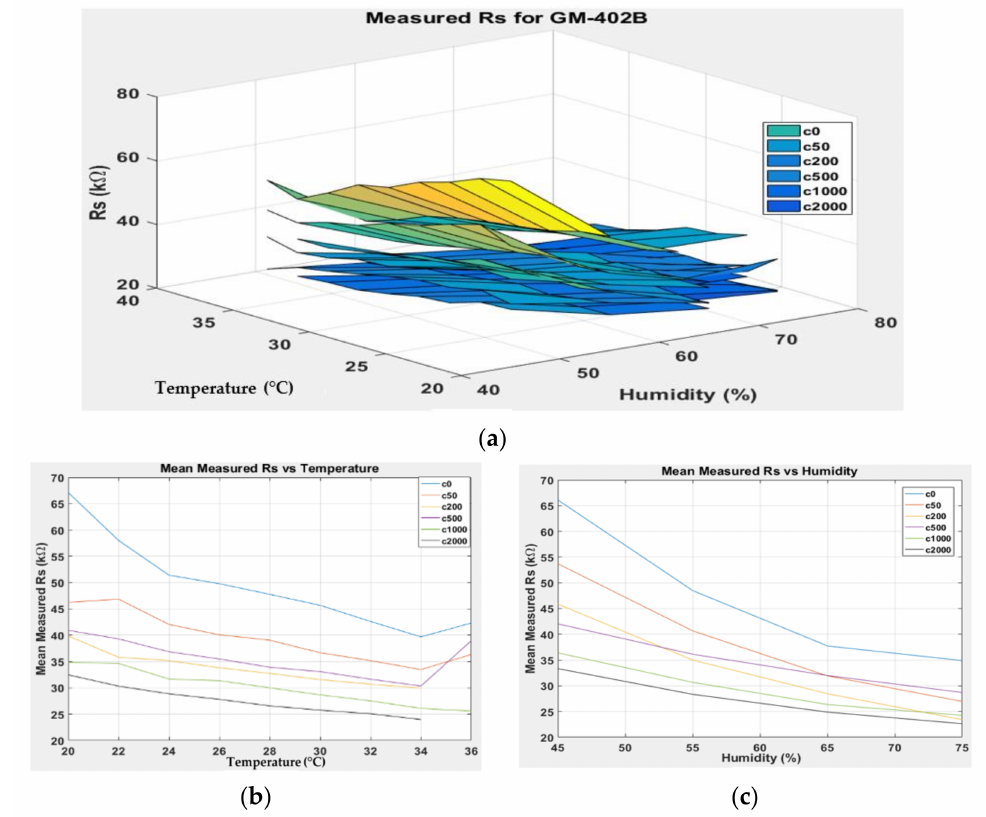
Figure 8. ( a ) Three-dimensional surface graph of GM-402B measured R S at varying temperature and humidity levels and different ethanol solution concentrations, ( b ) mean of measured R S versus temperature, and ( c ) mean of measured R S versus humidity.